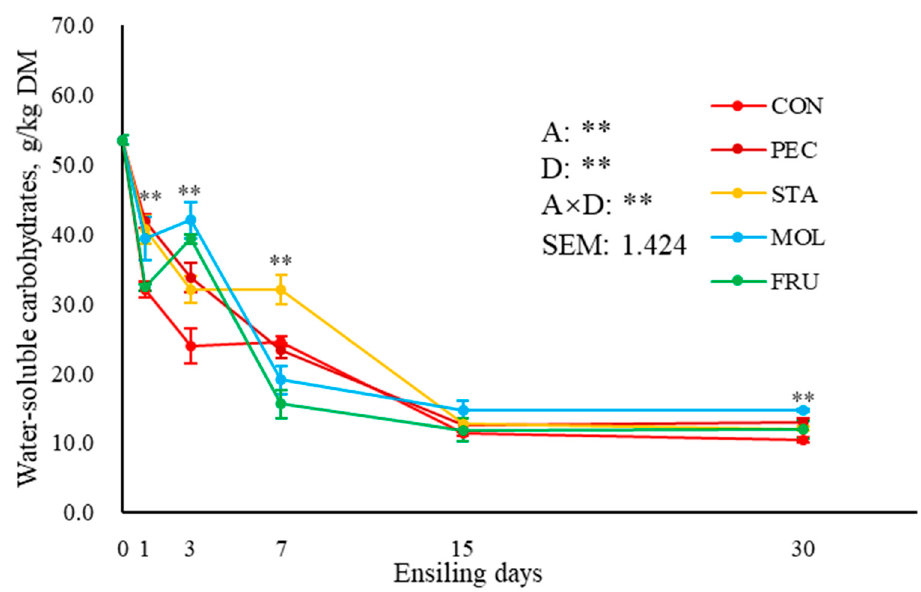
Figure 4. Effect of additives on the water-soluble carbohydrates (WSC) content during ensiling of alfalfa. DM, dry matter; CON, control; PEC, pectin; STA, starch; MOL, molasses; FRU, fructose. A denotes significance of additives; D, denotes significance of ensiling days; A × D denotes the interactive effect between additives and ensiling days. SEM, standard error of means. The asterisks (** p ≤ 0.01) indicate the significance of additives and ensiling days and their interaction effects, and the difference at the specified ensiling day.